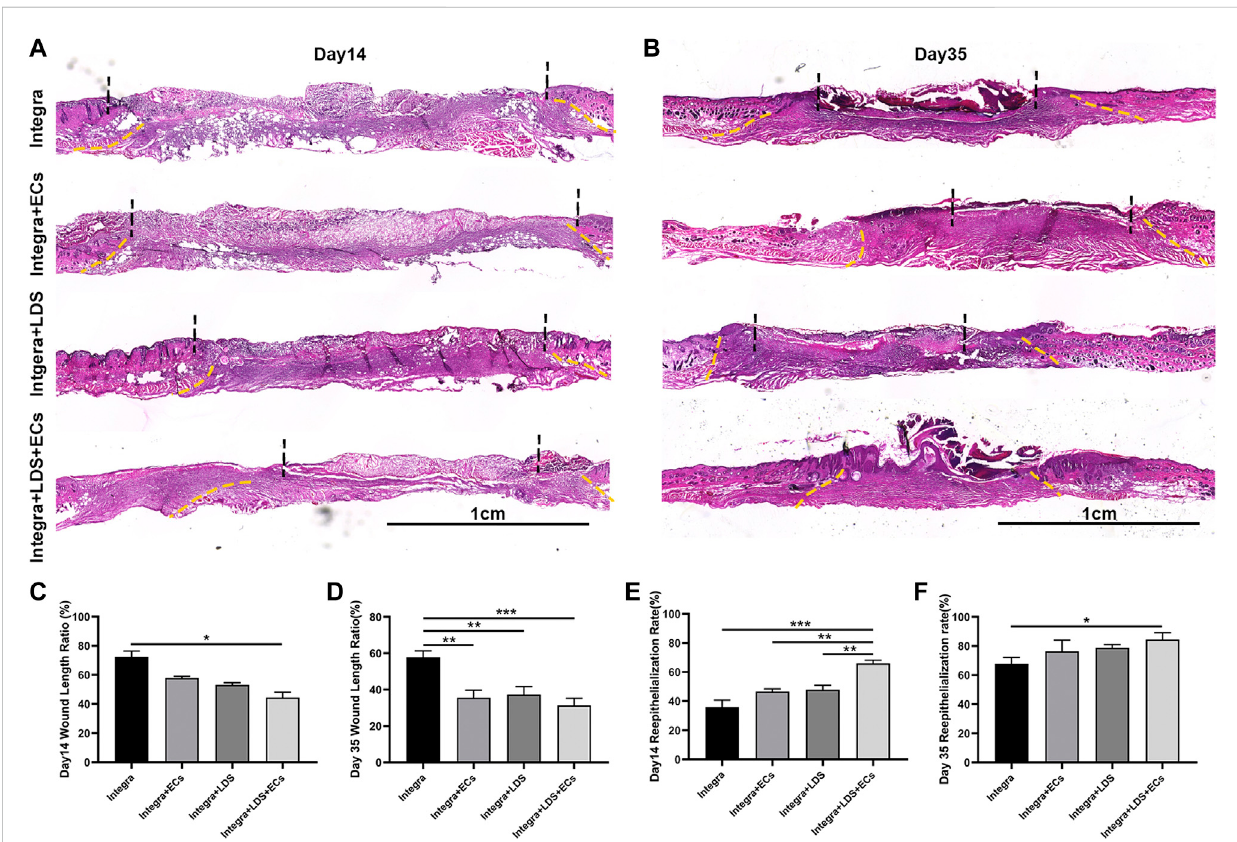
FIGURE 4 Histological evaluation of wound regeneration at Day 14 and Day 35. (A,B) Hematoxylin and eosin (H&E) staining was performed at Day 14 and Day 35post-woundingforfourgroups.Thewoundareaandnormaltissuewereseparatedbyyellowdotlines.Theun-epithelializedareaandre-epithelialized area were separated by black dot lines. Scale bar = 1 cm. (C,D) Quanti fi cation of the wound length at Day 14 and Day 35. (E,F) Quanti fi cation of the re- epithelialization at Day 14 and Day 35. Data are expressed as mean ± SEM. * p < 0.05, ** p < 0.01, and *** p <